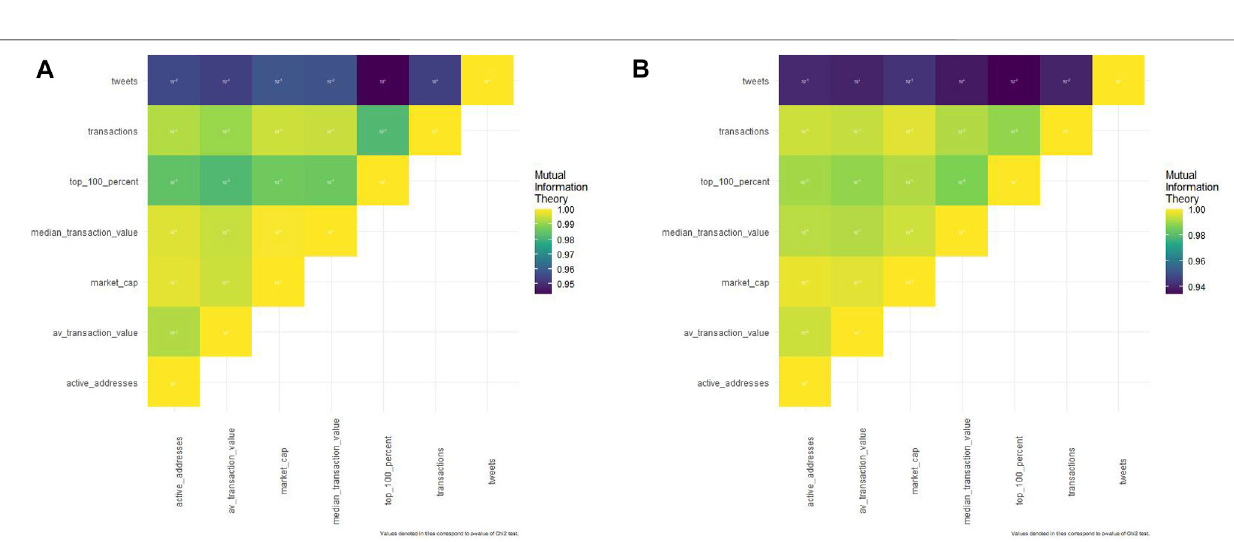
Frontiers in Blockchain |